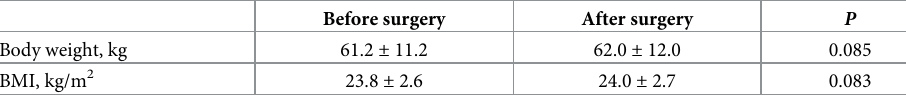
Table 6. Body weight and BMI before and after pituitary surgery. Before surgery After surgery P Body weight, kg 61.2 ± 11.2 62.0 ± 12.0 0.085 BMI, kg/m 2 23.8 ± 2.6 24.0 ± 2.7 0.083 Data are presented as mean ± SD. BMI, body mass